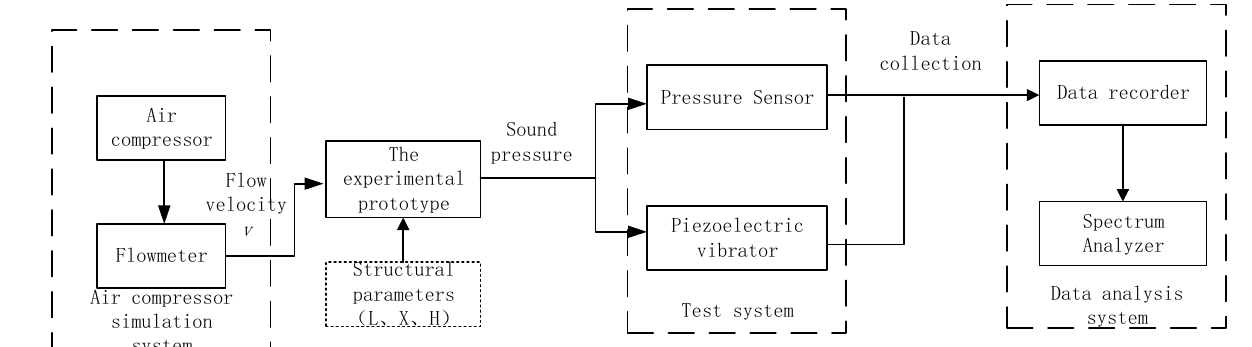
Figure 4. Block diagram of air compressor experimental test system.